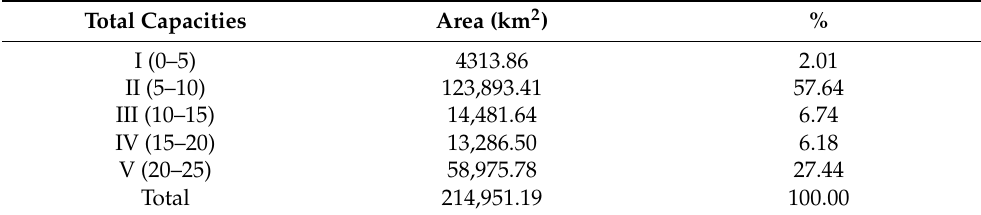
Table 5. Areas and proportions of different levels of cultural